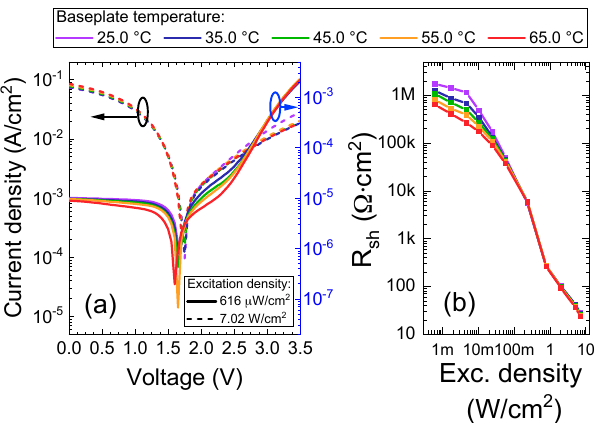
Figure 6. ( a ) I–V behavior at different baseplate temperatures with an excitation of 616 nW/cm 2 (solid lines, right scale) and 7.02 W/cm 2 (dashed lines, left scale) and ( b ) shunt resistance calculated from illuminated I–V characterizations.